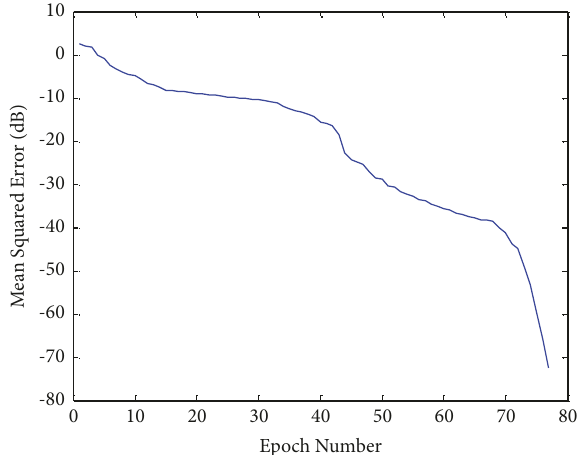
Figure 8: Learning curve for the binary classification neural network.